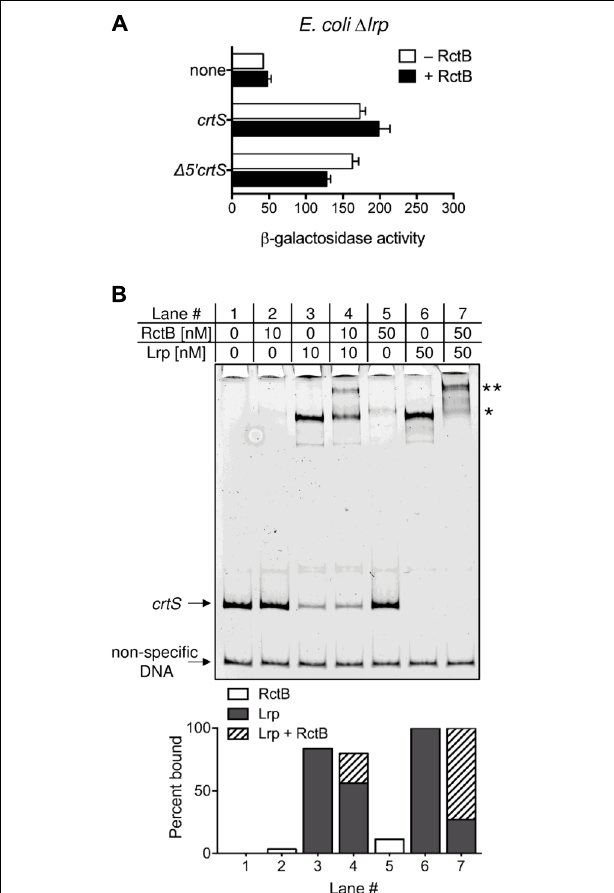
FIGURE 5 | Lrp enhances RctB binding to crtS . (A) Promoter activity of crtS (from P crtS ) was measured as in Figure 2 in E. coli (cid:49) lrp (CVC3259) carrying either the empty vector (none, pMLB1109), or the same vector carrying crtS (pBJH235) or its 5 (cid:48) truncated derivative (cid:49) 5 (cid:48) crtS (pPC067). Cells also had either a source of RctB (pRR24) or the corresponding empty vector (pPC020). Note that RctB, which was partially effective in repressing P crtS in WT, fails to repress the promoter in (cid:49) lrp . Data represent mean ± SEM from three biological replicates. (B) EMSA of 5 (cid:48) -FAM labeled crtS DNA (upper arrow) and non-specific DNA (lower arrow) with Lrp and RctB. Both Lrp (lanes three and six) and RctB (lanes two and five) were individually seen to bind crtS specifically. Note that the major Lrp bound band ( ∗ ) is super-shifted in the presence of RctB ( ∗∗ ). The intensity of the super-shifted band is much higher than the RctB bound band, indicating that RctB binds better to Lrp bound crtS . Shown below are percentages of probe bound to RctB alone (white columns), Lrp alone (gray columns) and, both Lrp and RctB (hatched